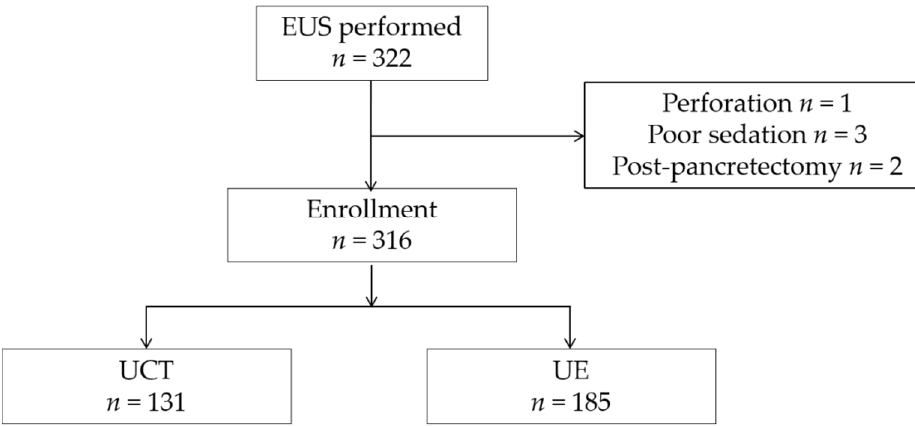
Figure 3. Flow diagram of the enrolled patients. EUS, endoscopic ultrasonography. Table 1. The clinical characteristics of the patients.